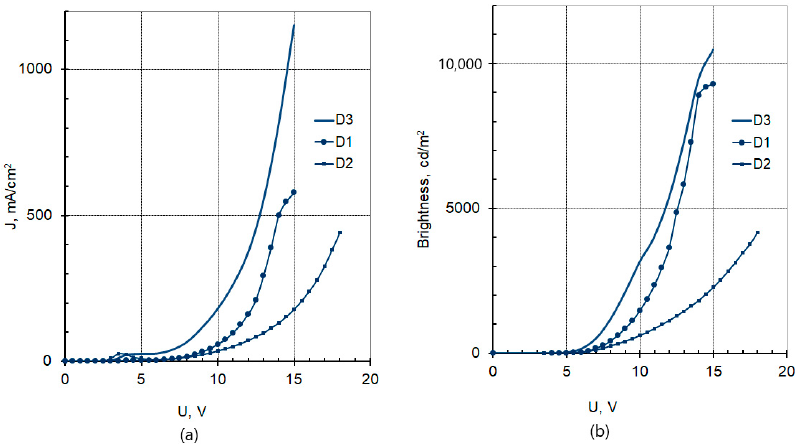
Figure 7. ( a ) Voltage-current density and ( b ) voltage-brightness characteristics of the OLEDs based on EML with the D1 – 3/ mCP composites.